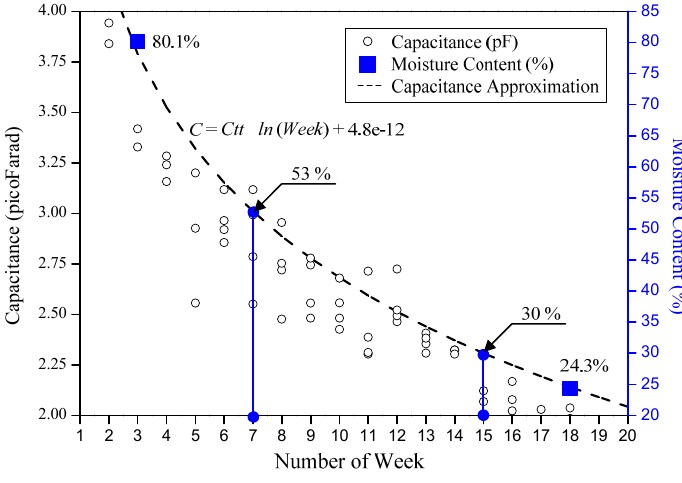
Figure 8. Graph of capacitance and moisture content of the fruitlet against week.